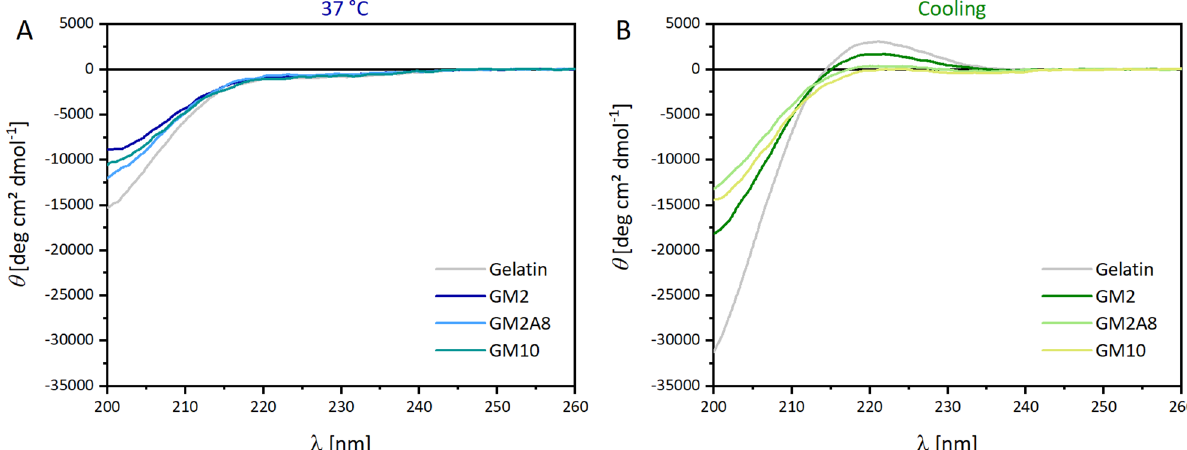
Figure 1. Molar ellipticity Ɵ of unmodified gelatin, GM2, GM2A8, and GM10. The spectra were recorded at 37 °C ( A ) or after the temperature protocol, whereby the 37 °C warm solution was cooled to 21 °C for 20 min followed by cooling to 4 °C for 40 min ( B , cooling). For gelatin and GM2 a clear positive signal around 220 nm was detected after cooling, which suggested the presence of alpha helices. The signal was absent for all solutions measured at 37 °C, and the negative molar ellipticity of all solutions around 200 nm emphasized the presence of random coil structures. The figure was created with Origin 2019b (https ://www.origi nlab.com/2019b